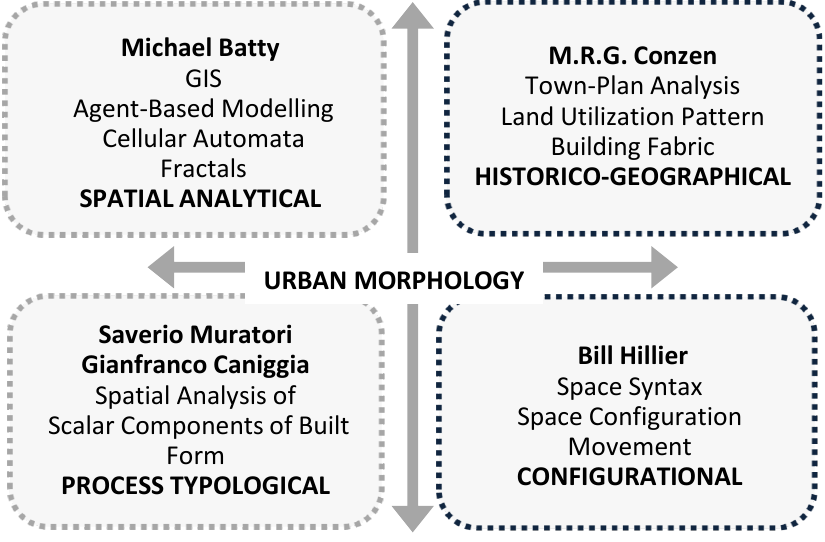
Figure 1 Approaches to urban morphology (adopted from Kropf,